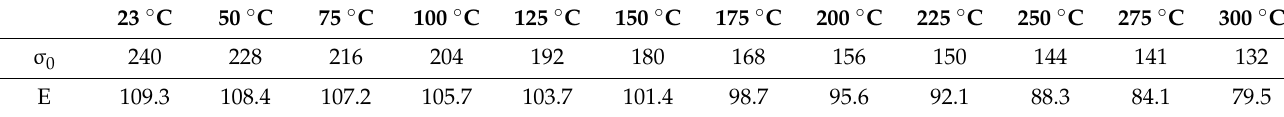
Table 2. Yield stress [MPa] and Young modulus [GPa] values for different temperatures.